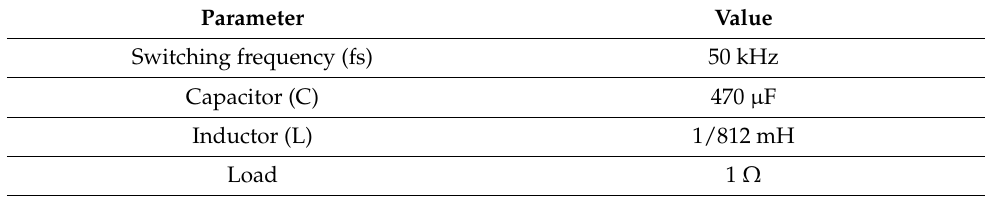
Table 2. Boost converter parameters [33,34].